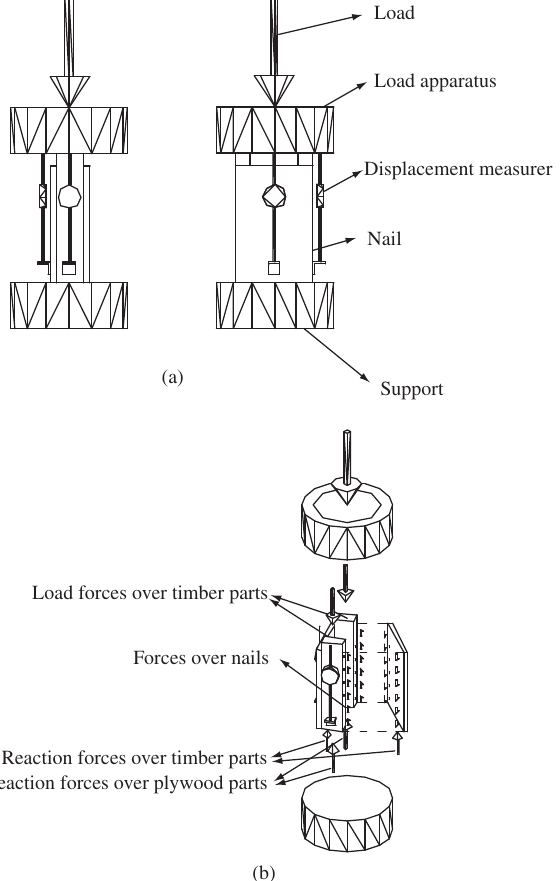
Figure 7. Scheme of the test. a) scheme of test setup; and b) scheme of forces.